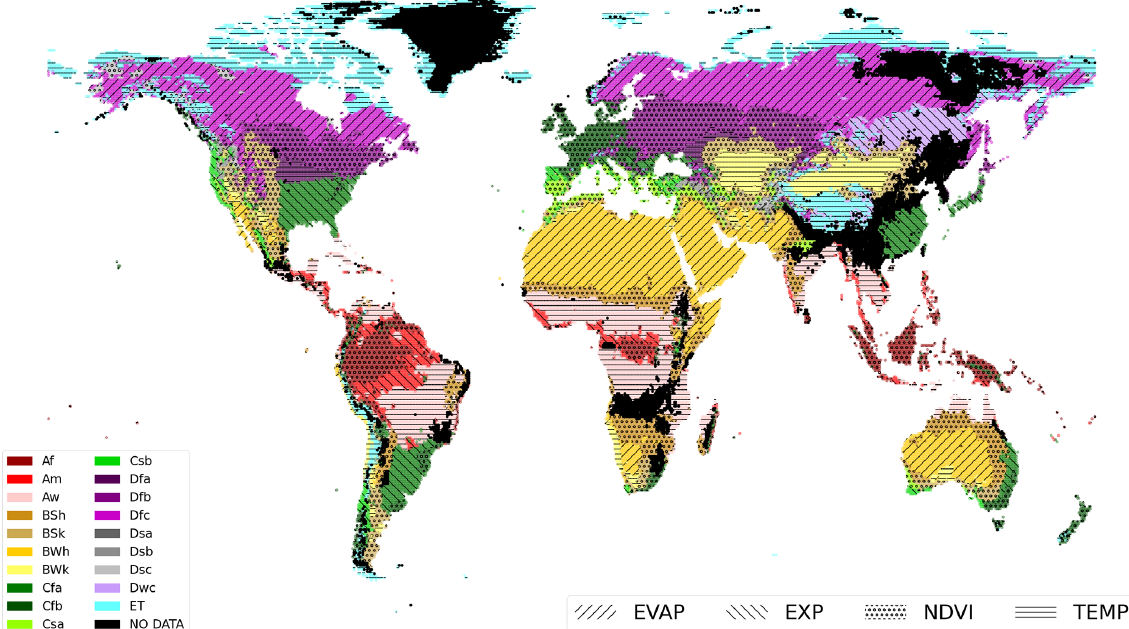
Figure 6. World map of the best-performing ANN models per climate class based on the mean correlation change rate; colors correspond to climate classes (see Appendix A), and hatches correspond to the most contributive input to the predictions, namely, EVAP (evaporation efficiency), EXP (exponential filter SWI), NDVI, and TEMP (surface soil